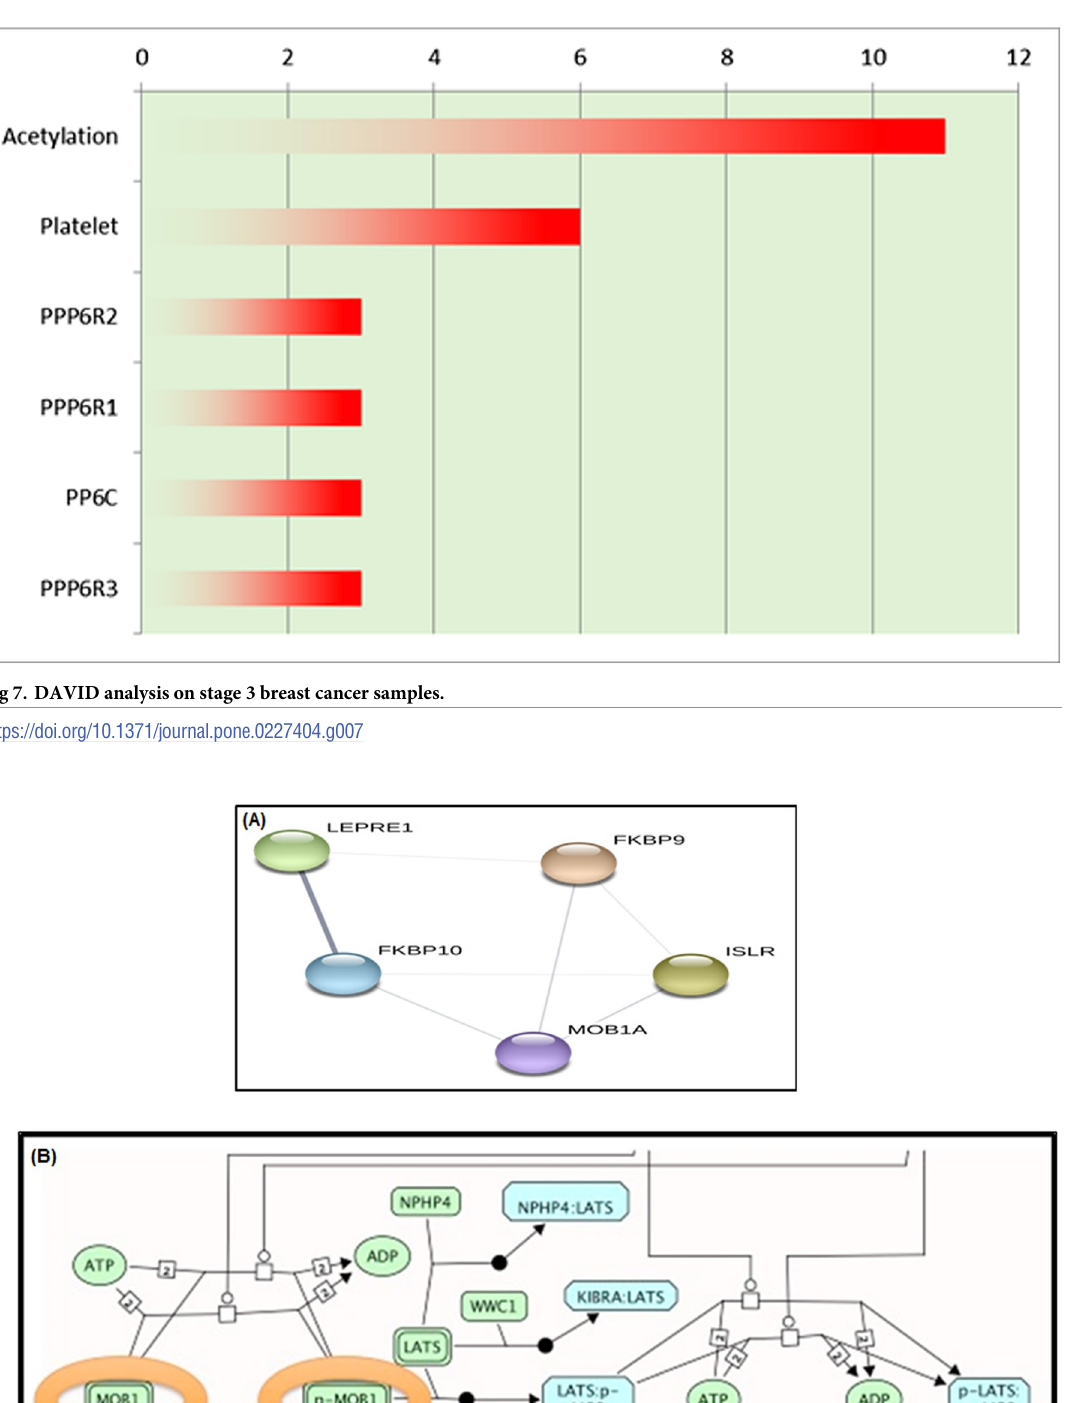
PLOS ONE | https://doi.org/10.1371/journal.pone.0227404 January 16,